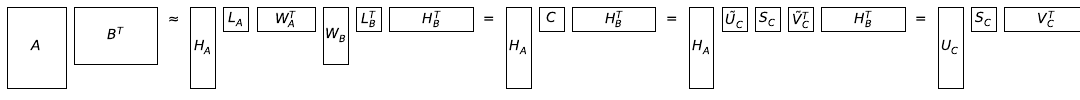
Figure 10. Visualizing the calculation of an approximate SVD for the product of two fields using dimensionality reduction.